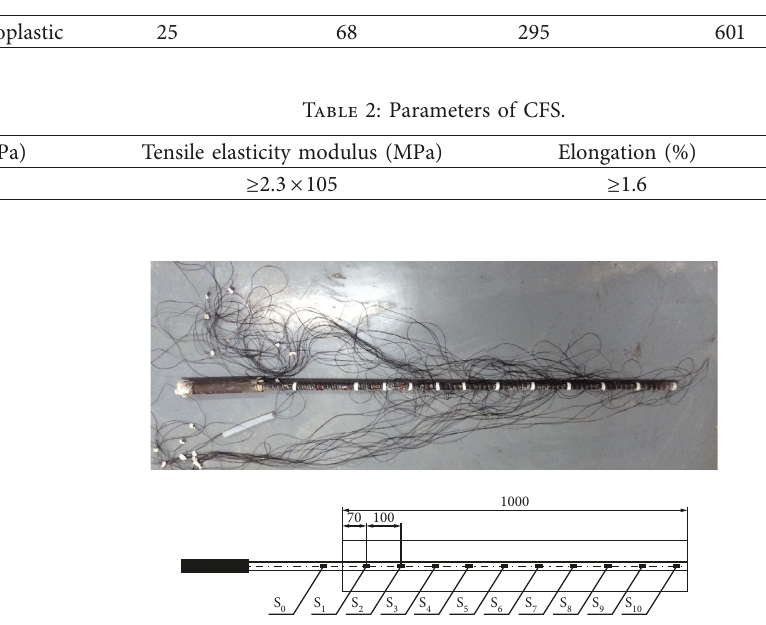
Figure 1: Strain gauge bonding image (unit: mm).